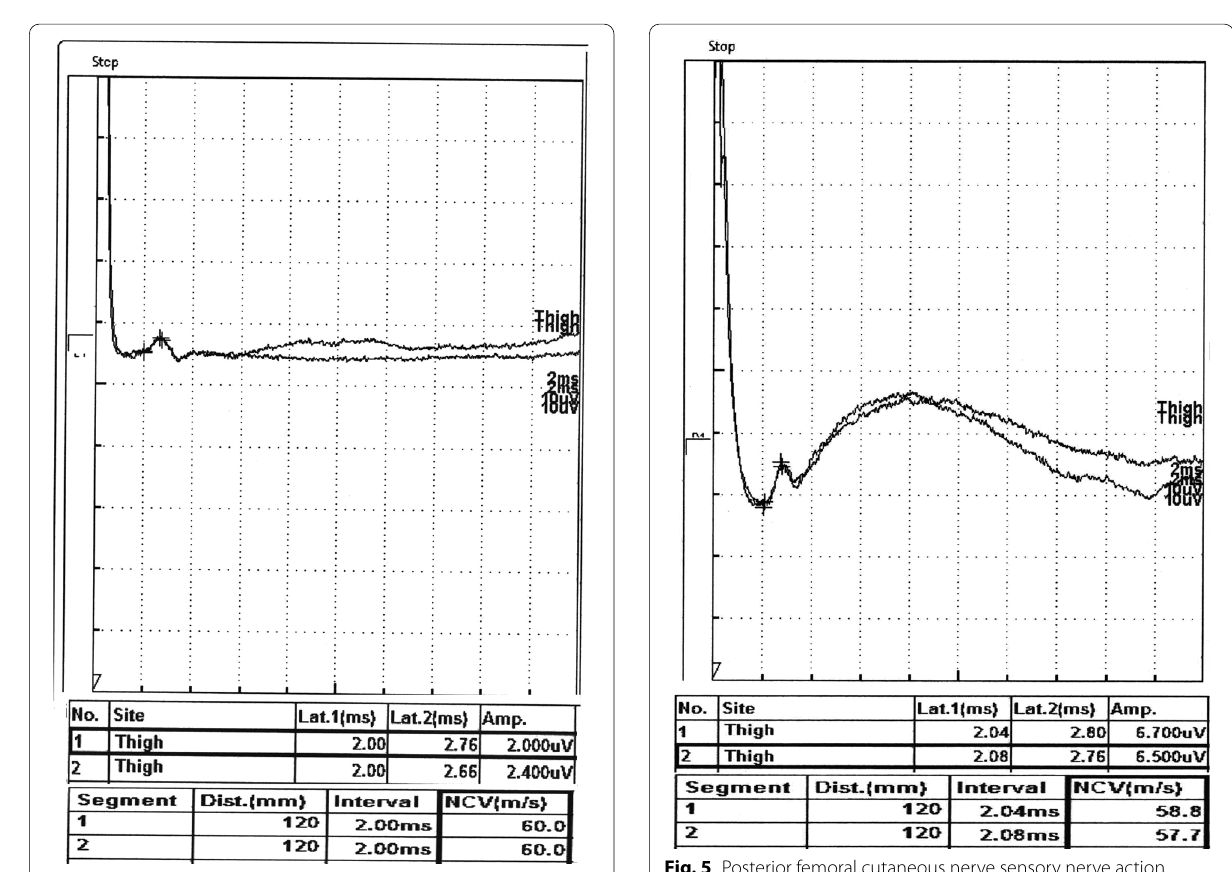
Fig. 4 Posterior femoral cutaneous nerve sensory nerve action potentials of an apparently healthy male participant. It is not followed by volume-conducted motor potential obtained from hamstring muscles. Lat. 1, onset latency; Lat. 2, peak latency; Amp., amplitude;